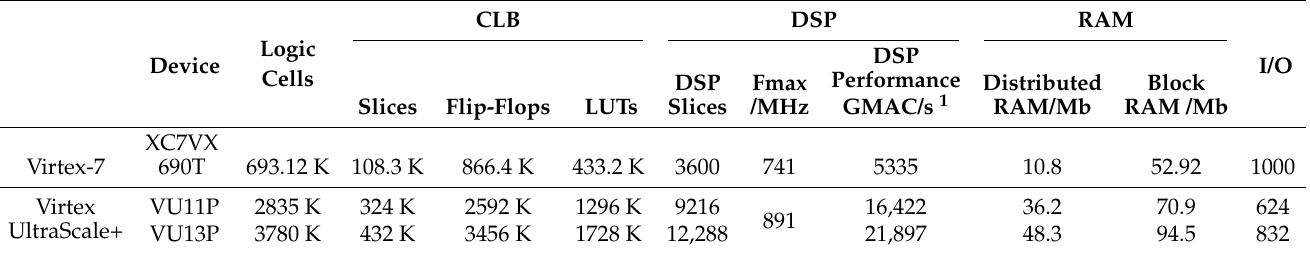
Table 2. Several available commercial FPGAs for